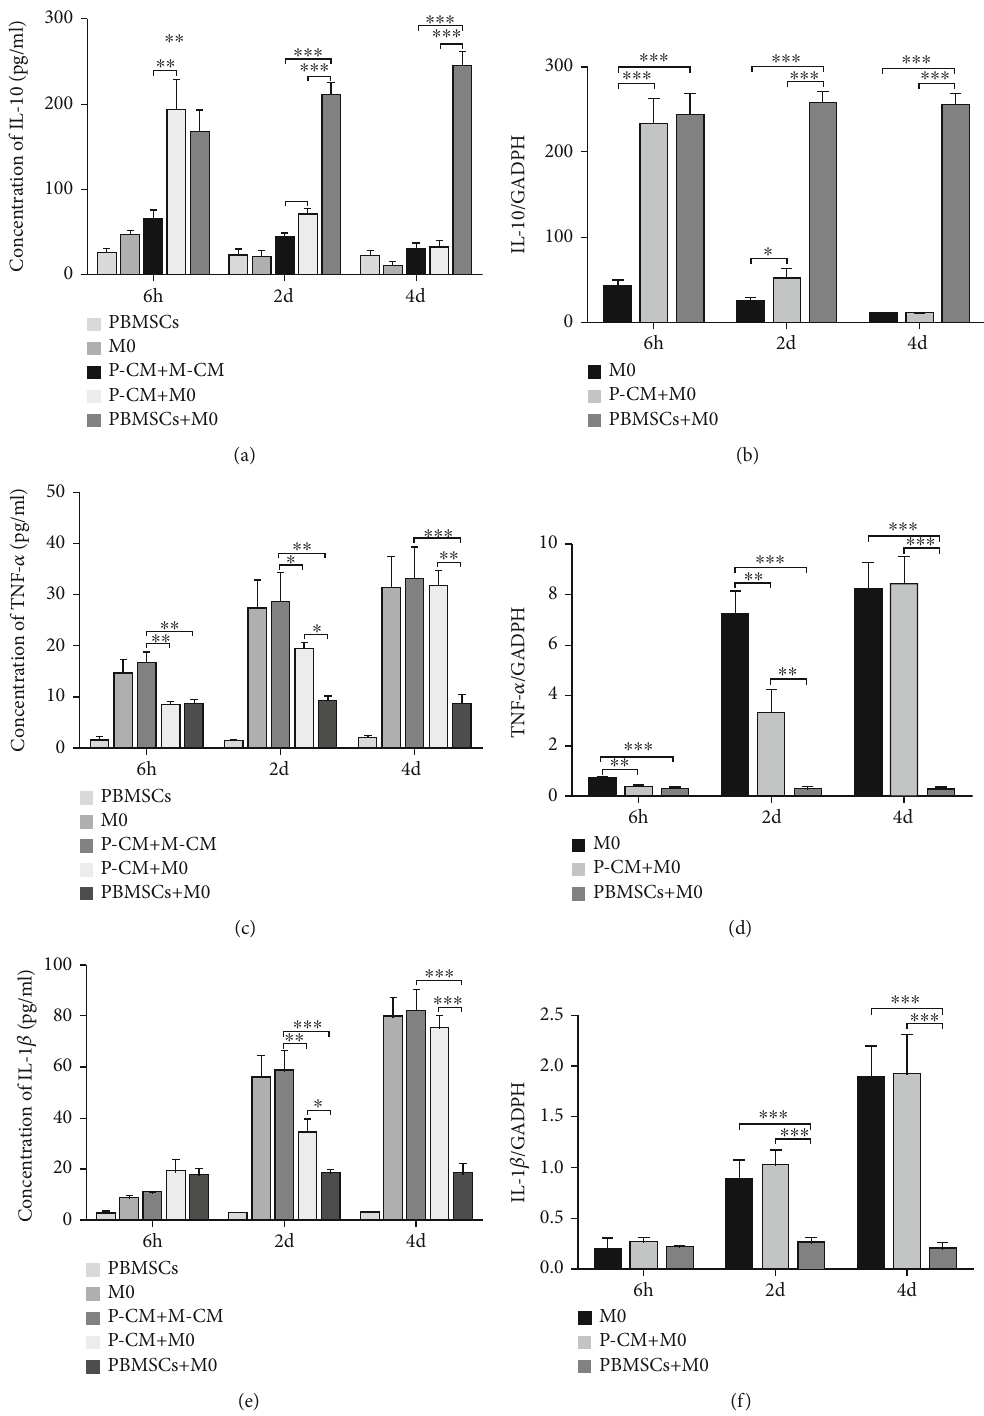
Figure 2: E ff ect of various coculturing conditions on the secretion and expression of in fl ammatory cytokines by macrophages. (a, c, e) Concentrations of IL-10 (a), TNF- α (c), and IL-1 β (e) in the supernatant of various coculture groups were measured by ELISA at 6h, 2d, and 4 d. (b, d, f) The expression levels of IL-10 (b), TNF- α (d), and IL-1 β (f) in macrophages from various coculture groups were measured by RT-qPCR at 6h, 2d, and 4 d. Graphs show the mean ± standard deviation ; n = 3 ; ∗ P < 0 : 05, ∗∗ P < 0 : 01, and ∗∗∗ P < 0 : 001 . ELISA: enzyme-linked immunosorbent assay; GAPDH: glyceraldehyde 3-phosphate dehydrogenase; IL: interleukin; M-CM: Roswell Park Memorial Institute-1640 media with 10% fetal bovine serum and 20% L929 conditioned media; P-CM: PBMSC-conditioned media; PBMSCs: peripheral blood-derived mesenchymal stem cells; RT-qPCR: real-time quantitative polymerase chain reaction; TNF: tumor necrosis